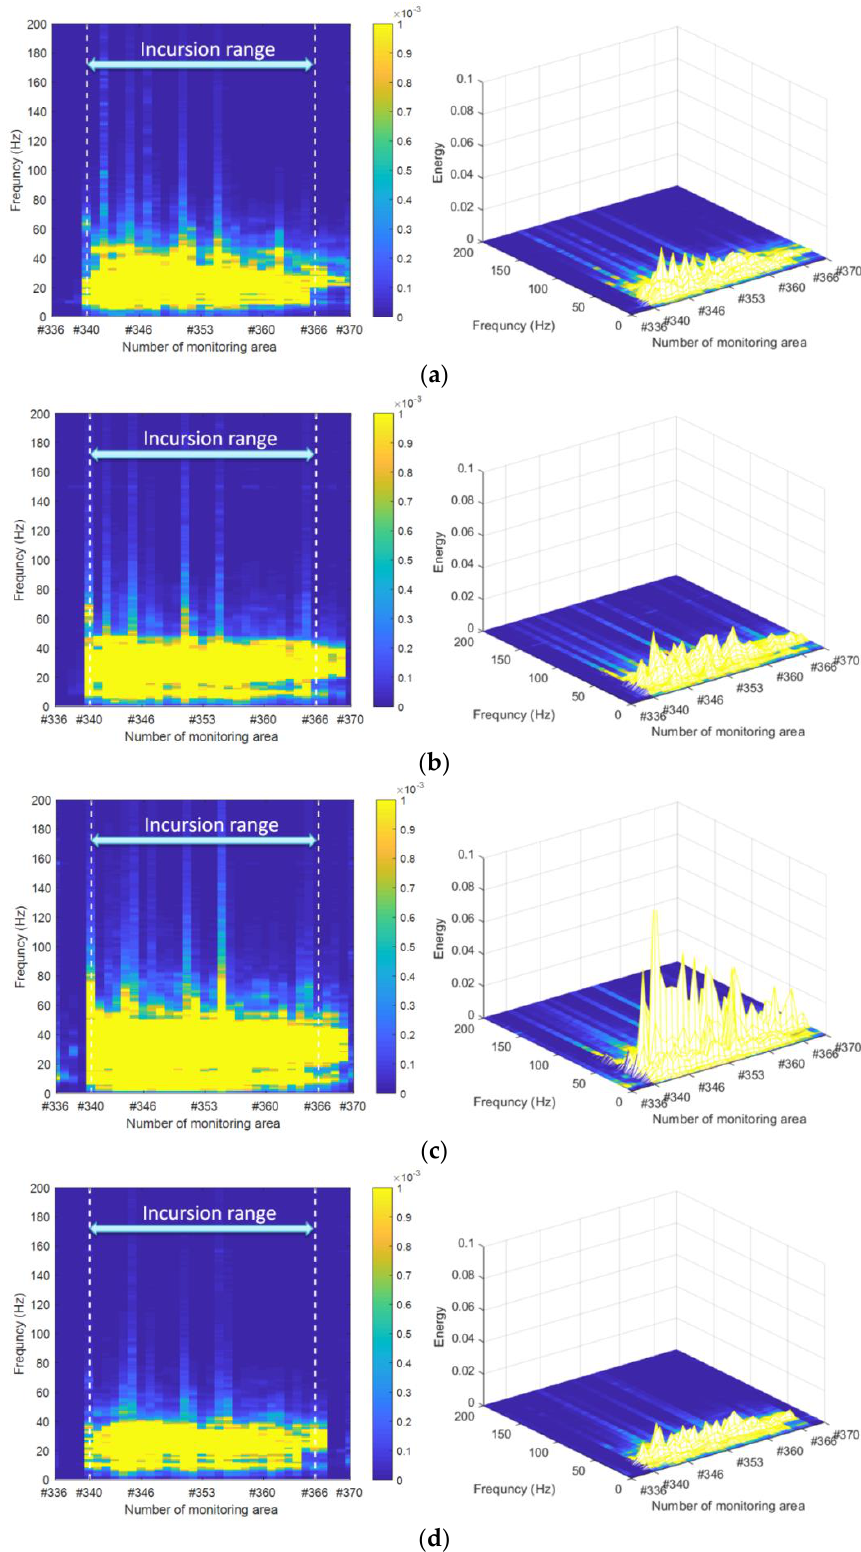
Figure 9. Vibration intensity versus space and time under different intrusion scenarios: ( a ) single person walking; ( b ) four people walking; ( c ) single person jogging; ( d ) single person walking along the other side.